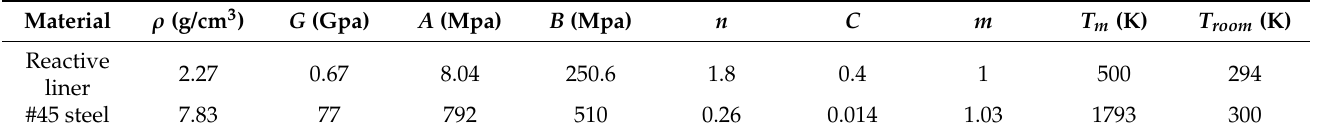
Table 2. Johnson–Cook strength model parameters of the reactive liner and #45